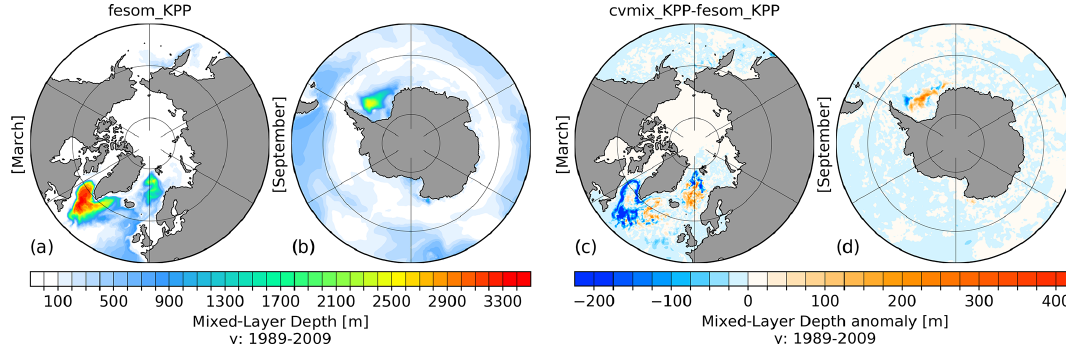
Figure 10. Northern Hemisphere March (a) and Southern Hemisphere September (b) mixed-layer depth (MLD) for the fesom_KPP im- plementation and the corresponding anomalous MLD between cvmix_KPP and fesom_KPP implementation (c, d) averaged for the period